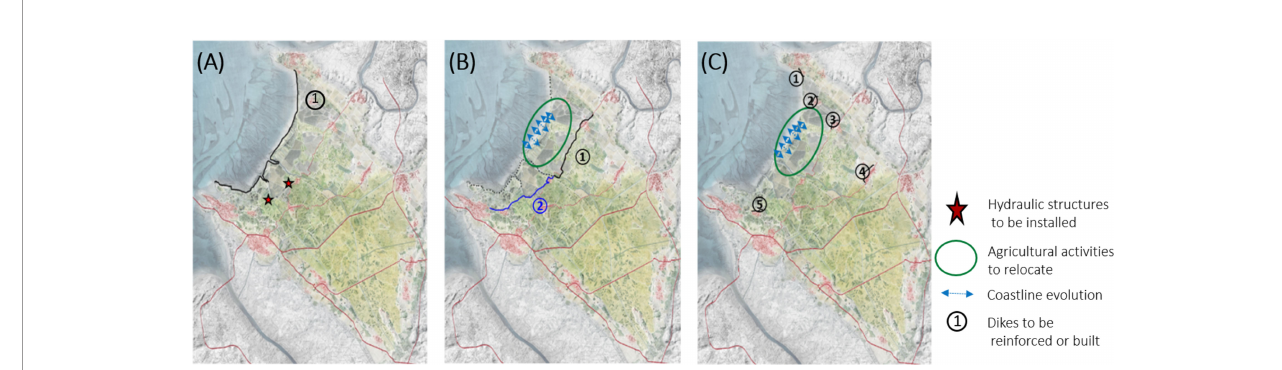
FIGURE 4 | Adapted from the local stakeholders workshop. (A) Proposition P1: reinforcement of the sea-dike and hydraulic infrastructures identi fi ed by red stars; (B) P2: Reinforcement of a road-dike (represented by the black and blue lines n°1 and n°2), without maintenance or reinforcement of the existing sea-dikes; (C) P3: Proposition of coastal defenses located around identi fi ed issues, without maintenance or reinforcement of the existing sea-dikes. Agricultural activities to relocate are identi fi ed by a green circle and blue arrows represent the